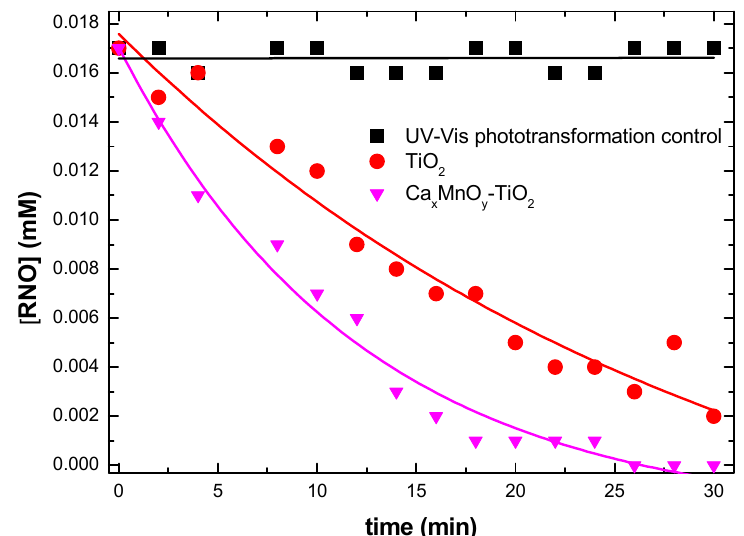
Figure 10. HO • detection by means of RNO bleaching under UV-Vis irradiation for Ca x MnO y -TiO 2 , TiO 2 and transformation control.